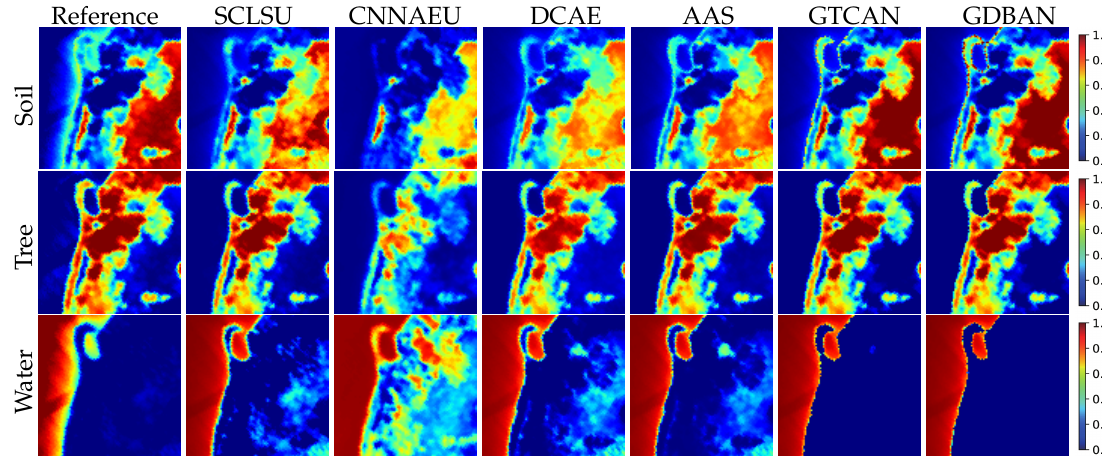
Figure 6. Reference and estimated abundance maps on Samson data by different